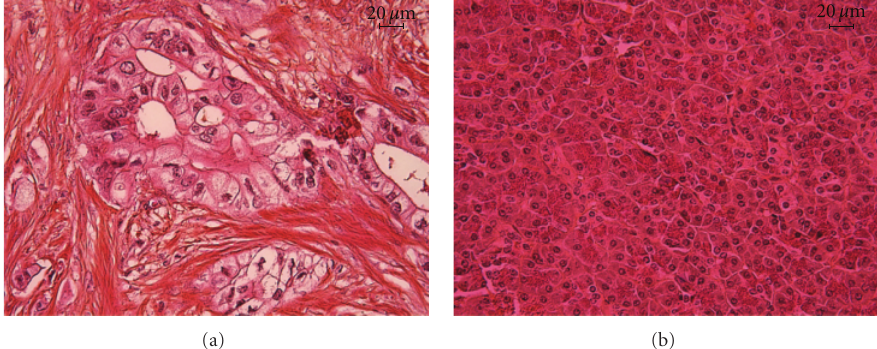
Figure 2: PDAC tissues contain an extensive fibrotic component. Normal pancreas from individuals deceased from hypothermia, and PDAC tissues were stained using Sa ff ron and Hematoxylin. Photographs show the staining for PDAC (a) and normal pancreas (b), the fibrotic tissue is visualized as orange. Size bar 20 μ